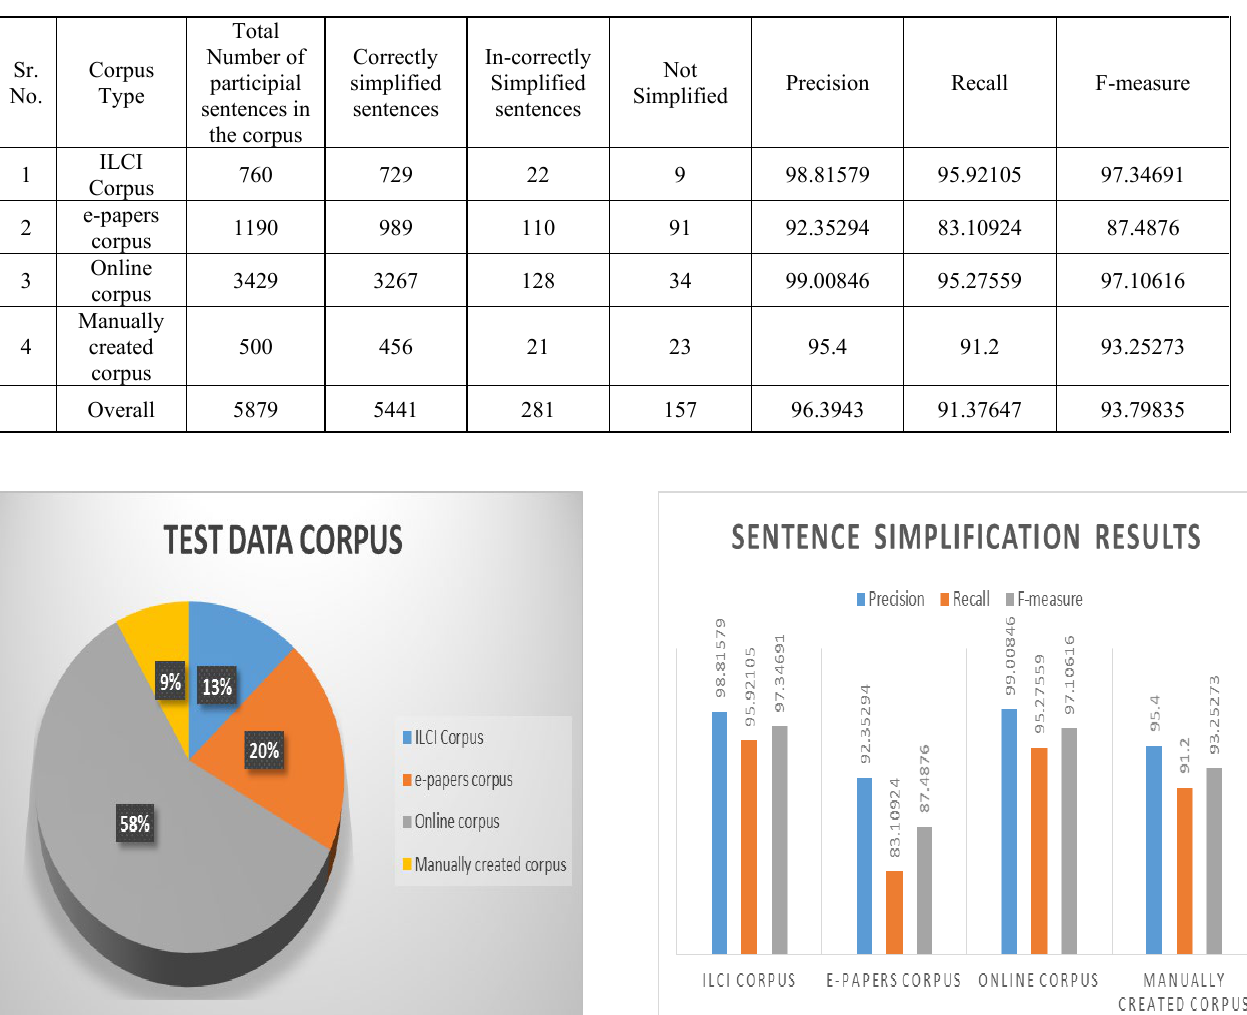
Table 7. Results obtained on testing the system